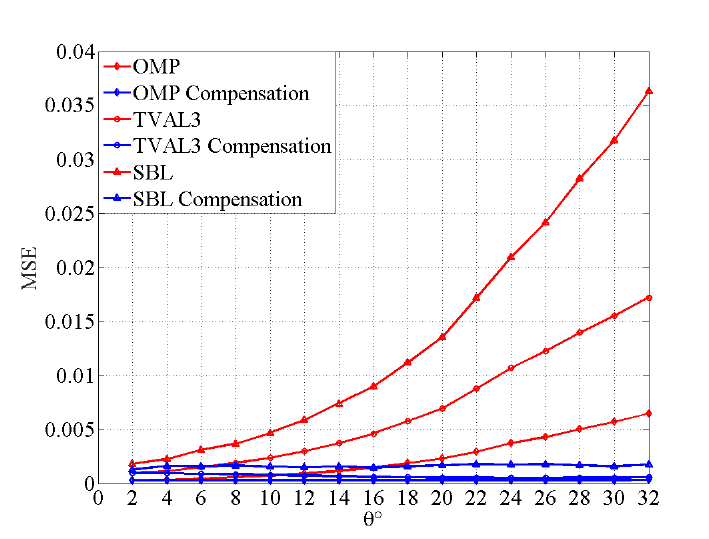
Figure 4. Influence of different θ with OMP algorithm, TVAL3 algorithm, SBL